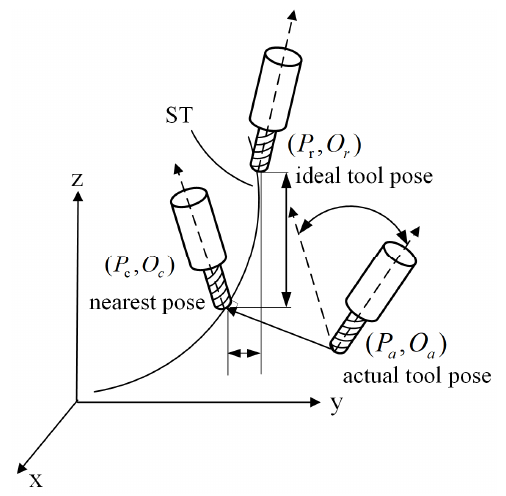
Figure 3. The geometric relationship diagram of CTCE.